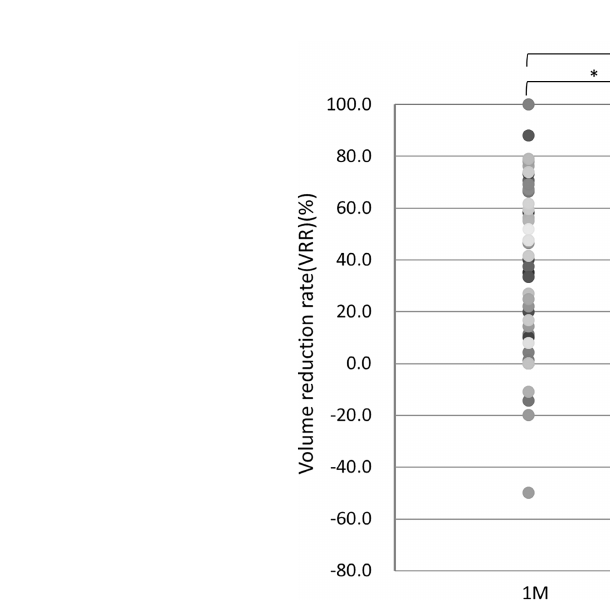
FIGURE 3 VRR at 1, 3, and 6 months of follow-up. *p value